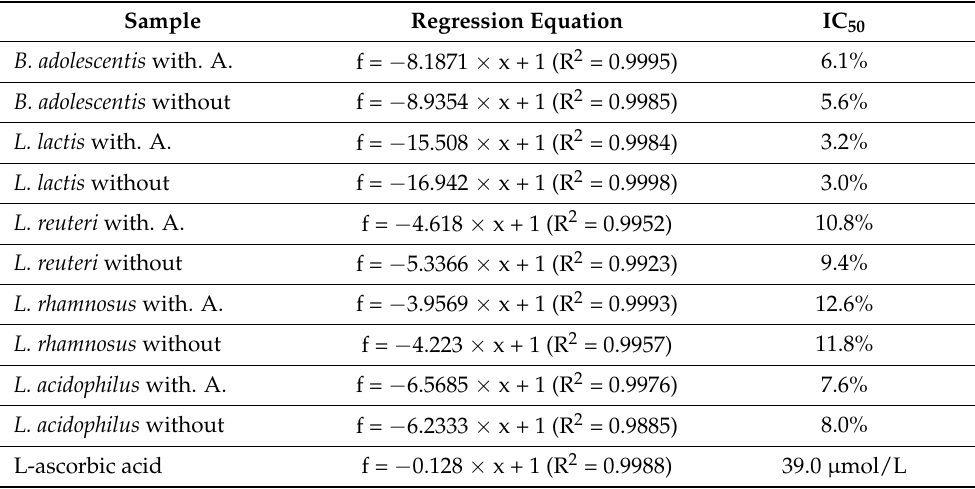
Table 2. The DPPH scavenging results of ferment